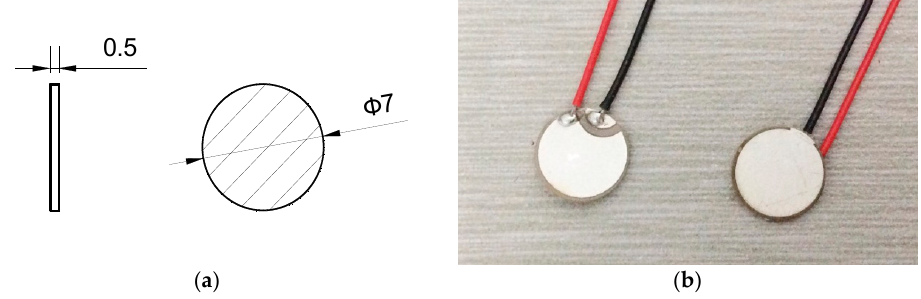
Figure 5. ( a ) The geometry of the PZT and ( b ) the outline of the PZT.